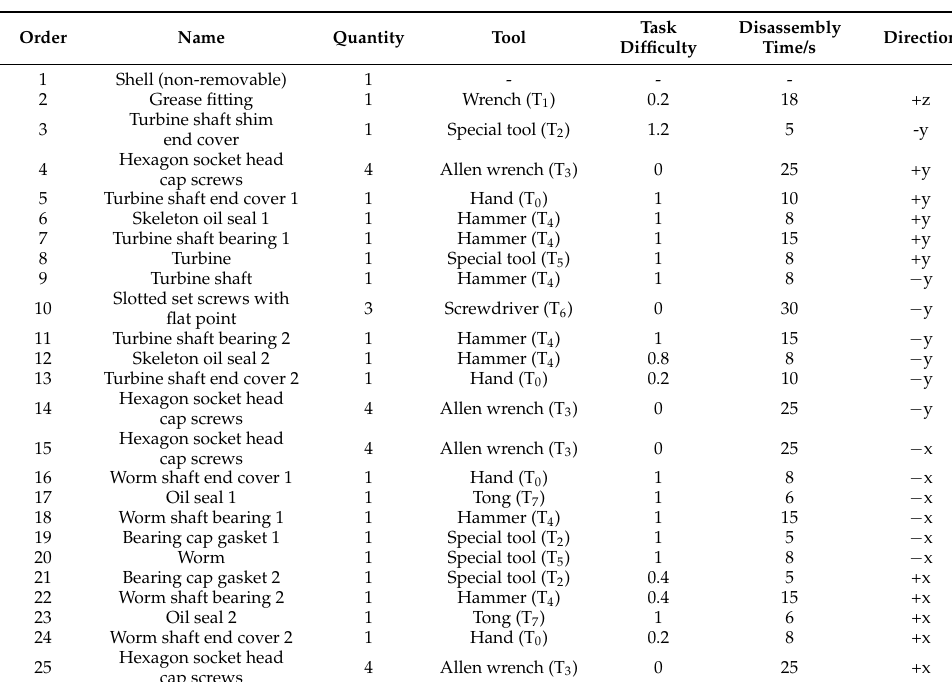
Figure 8. Hybrid diagram of worm reducer disassembly. Table 2. Parts of turbine